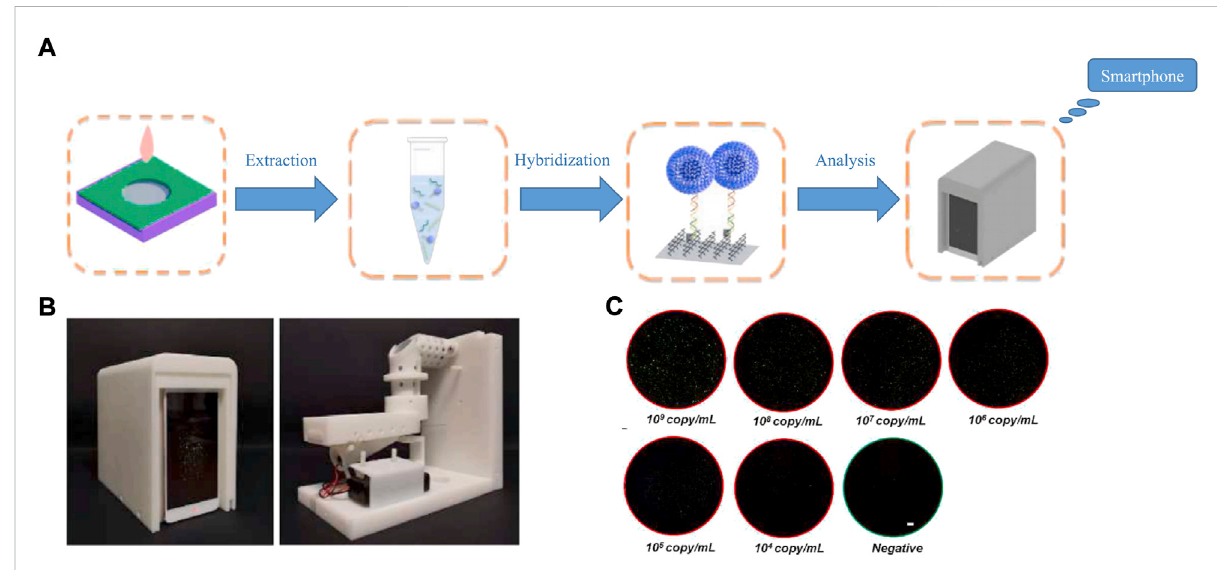
FIGURE 7 (A) Flow chart of the ampli fi cation-free smartphone-based detecting technique. (B) Portable fl uorescence nucleic acid detector. (C) Captured FoVs corresponding to different virus concentration. White bar represents 1 μ m. Copyright 2021 Elsevier